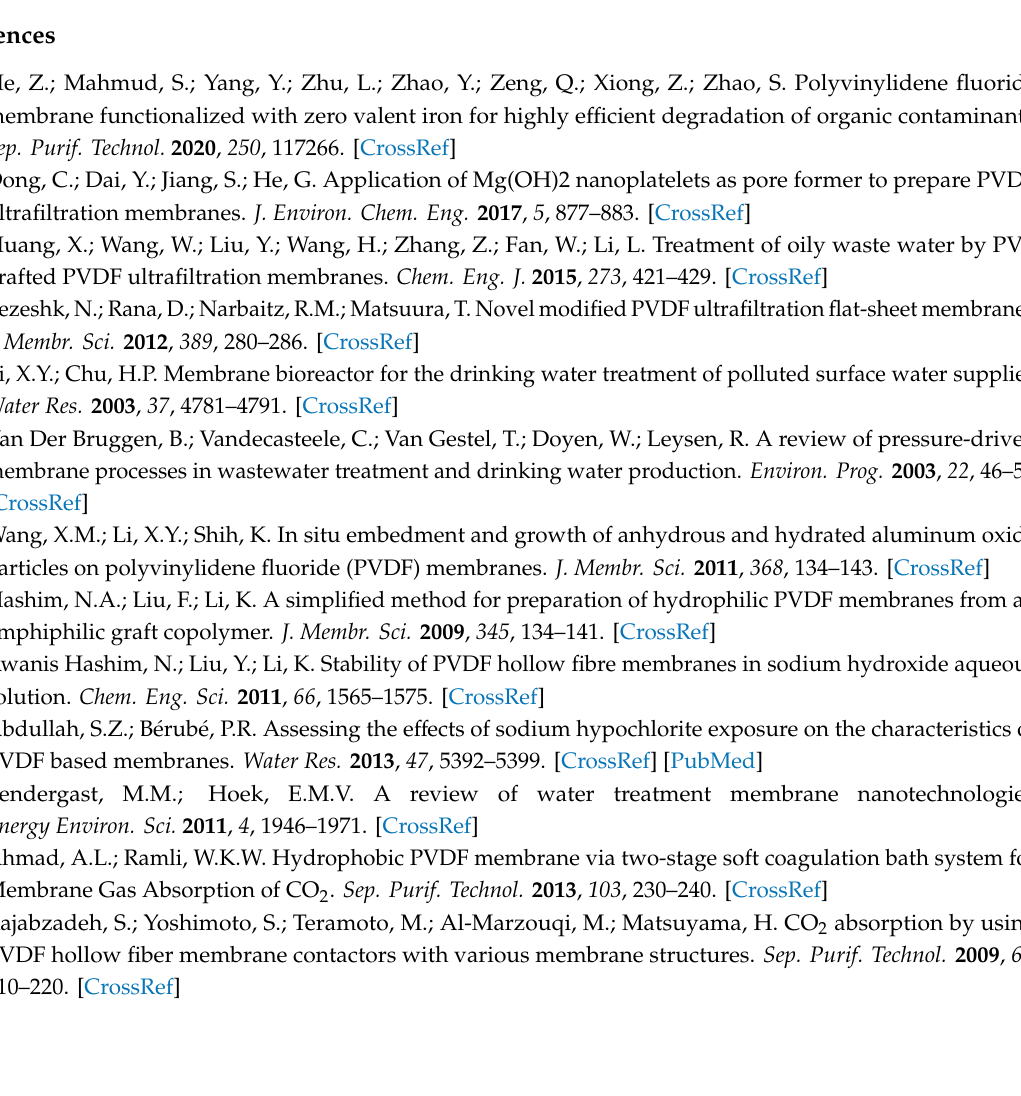
Figure S1: X-ray di ff raction spectra for neat and embedded membranes on exposure Days 28, 56 and 84. Figure S2: FTIR spectra of neat and embedded membranes on exposure Days 28, 56 and 84. Table S1: Di ff raction angles 2 θ of the characteristic